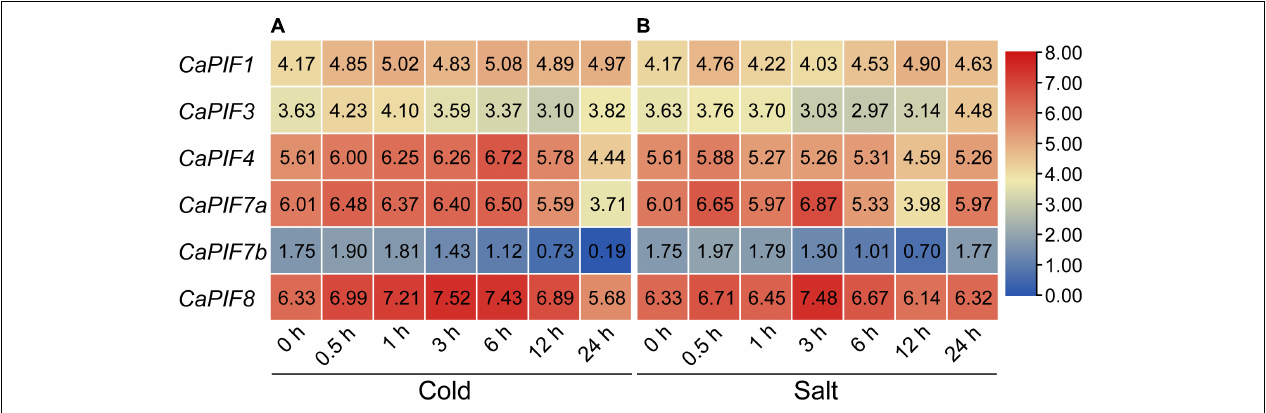
FIGURE 5 | Expression profiles of CaPIF genes under cold (A) and salt (B) stress based on RNA-seq data. Cold and salt stress treatments were applied on 40-day old seedlings of an elite breeding pepper line 6,421 treated with 10 ◦ C and 200 mM NaCl, respectively, and leaf samples were collected at 0, 0.5, 1, 3, 6, 12, and 24 h post treatment. Numbers in the boxes show the expression based on log2 (FPKM +1) values.